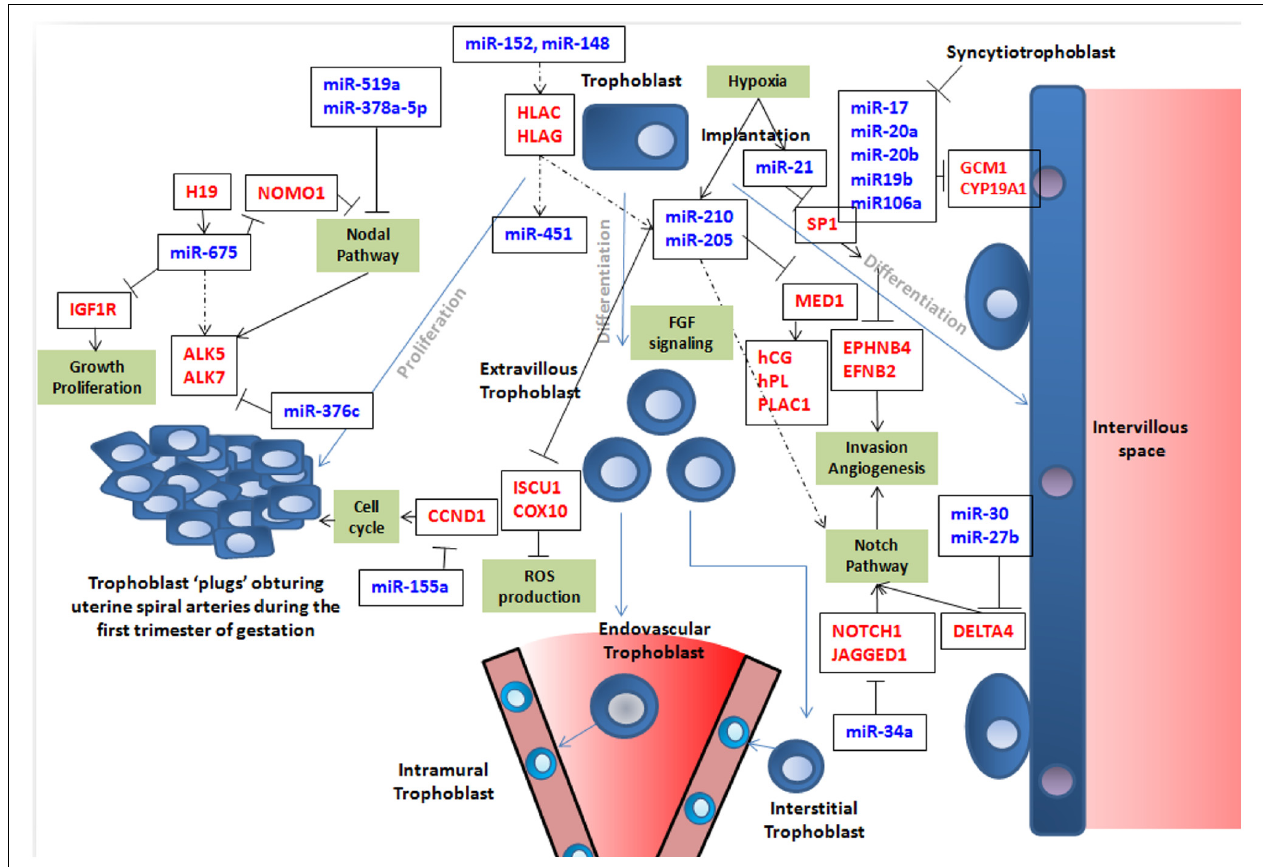
debated as nicely described by Pijnenborg etal. (2006). In the figure, crucial genes for cell cycle, Nodal, Notch, and FGF pathways, ROS production, invasion, and angiogenesis are presented in red. Crucial miRNAs are in blue. Blue arrows represent cell differentiation/proliferation pathways. Black arrows symbolize induction. When black lines are terminated by an orthogonal bar they represent inhibition. In the cases where the relation is not fully demonstrated, dotted arrows are used. It is clear that this vision is far from exhaustive, but attempts to depict current knowledge on the role of miRNA in building placental structure and ensuring efficient vascularization of this